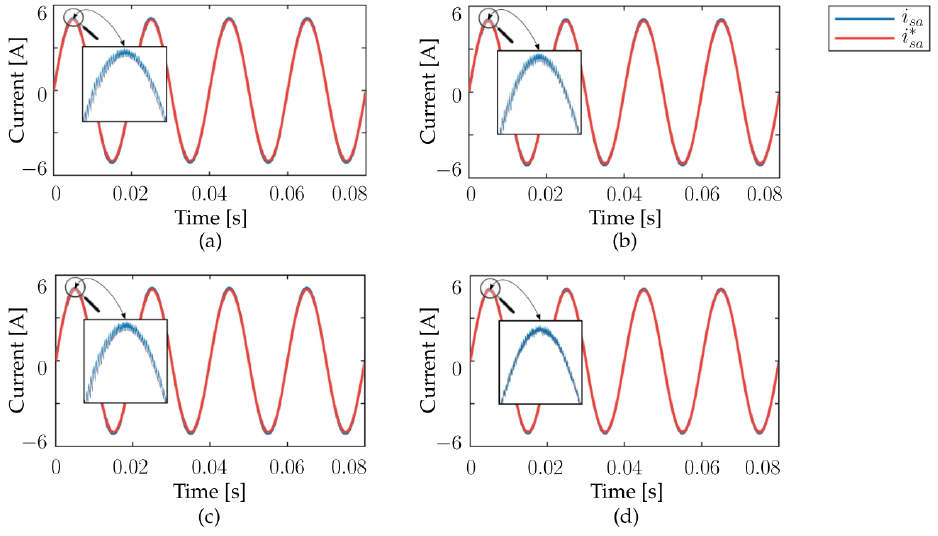
Figure 5. Gain adjustment results. ( a ) K 1 = 1 and ( b ) K 1 = 1000. ( c ) K 2 = 0.01 and ( d ) K 2 =